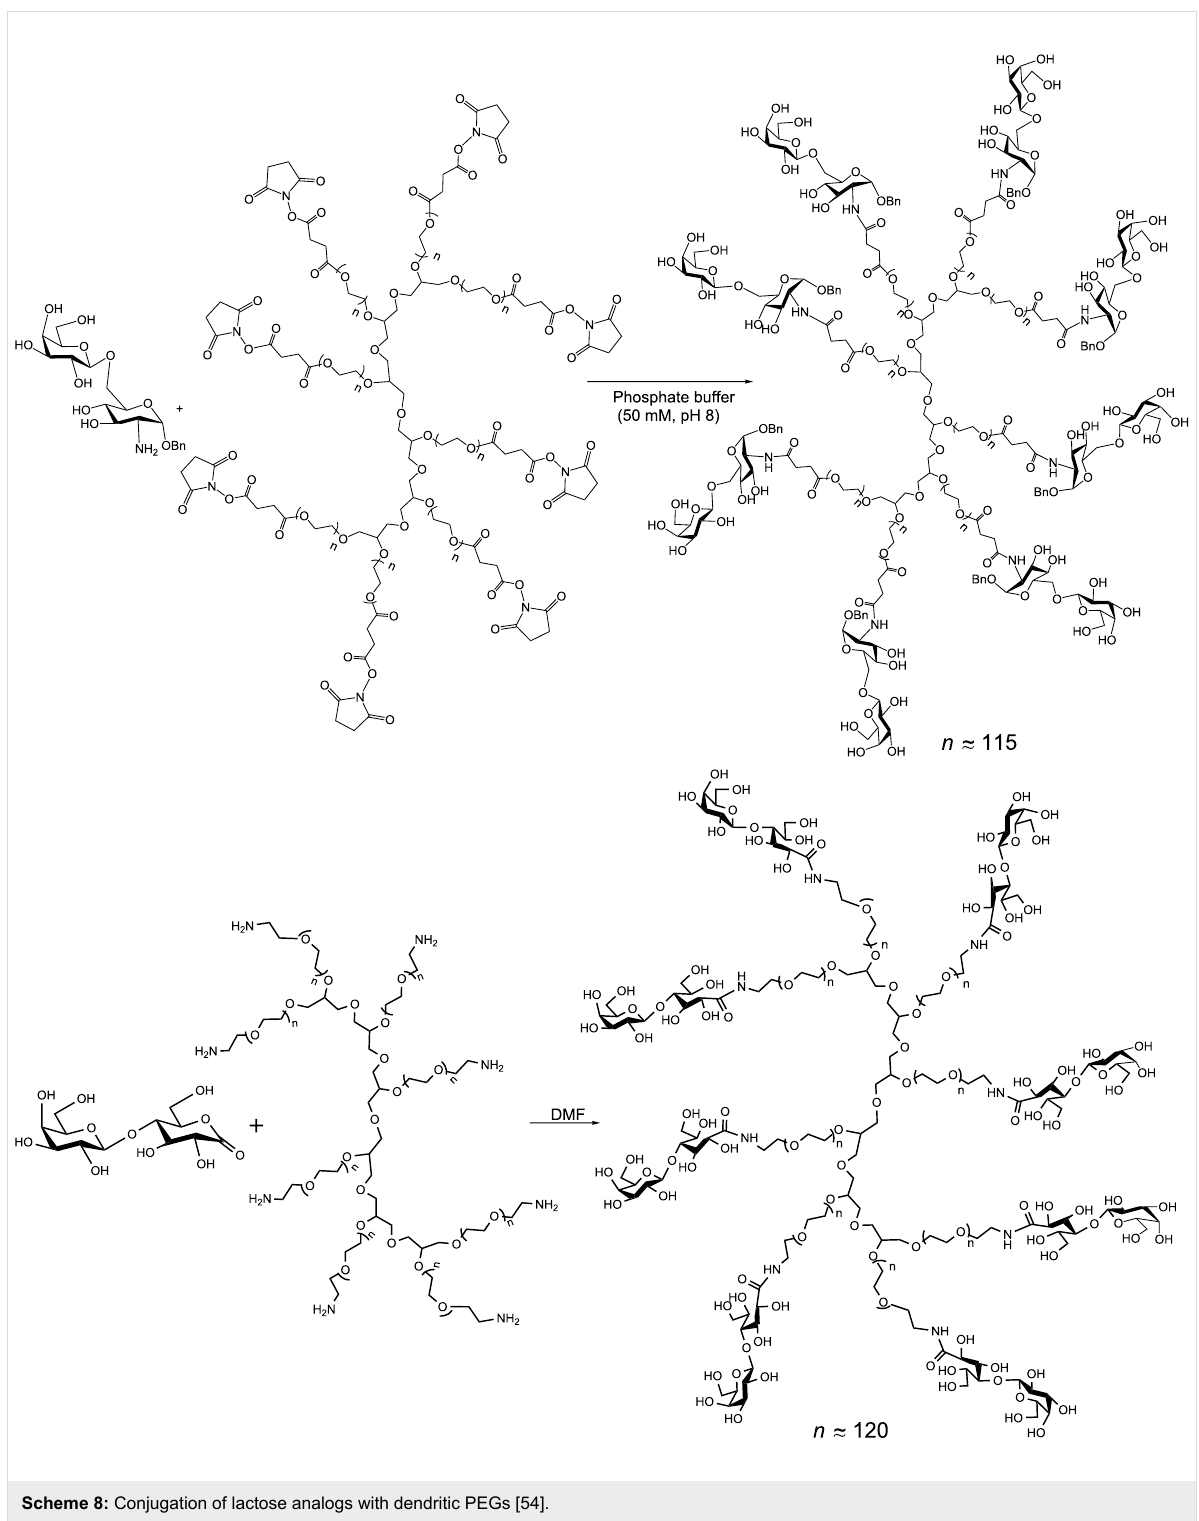
PEGylation of polysaccharides: PEGylation of chitosan and chitosan derivatives for pharmaceutical applications was described [22]. Chitosan is the polysaccharide obtained from